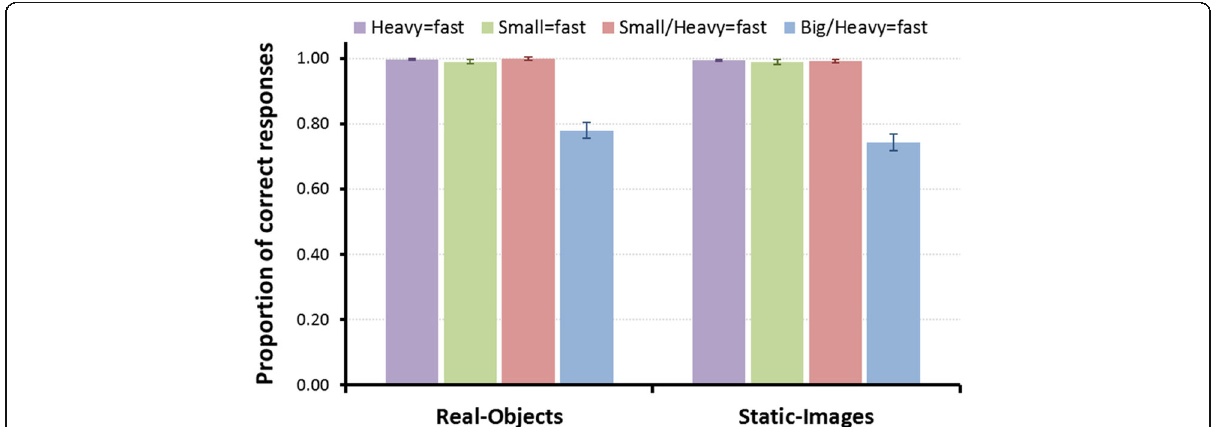
Fig. 7 Average proportion of correct answers in Experiment 3, separated by condition and trial type (see Fig. 1 for an example of each trial type). Trials differ in whether the faster object in a pair was heavy (heavy = fast), small (small = fast), small and heavy (small/heavy = fast), or big and heavy (big/heavy = fast). A mixed-design condition-by-trial analysis of variance (ANOVA) revealed a main effect of trial type. Specifically, we found worse performance on big/heavy= fast trials ( M = .76) than on all other trials ( M s = .99), F (3,153) = 156.20, p < .0001, η 2 = 0.75, 1- β = .99. No other effects were significant.